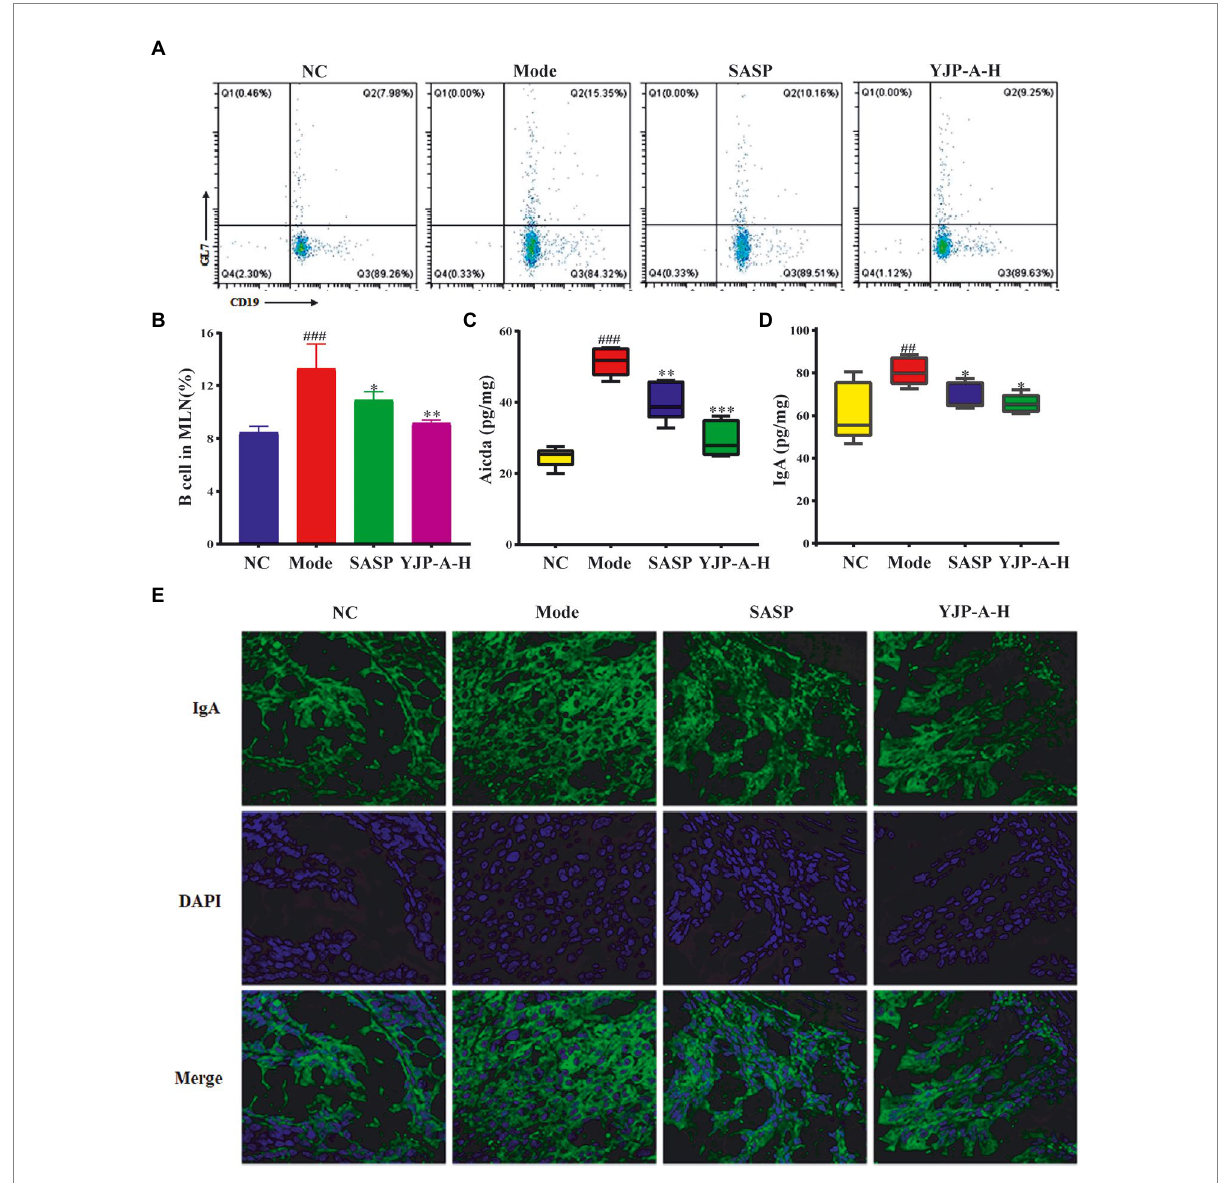
FIGURE 6 Effects of YJP-A-H on changes of B cells (A,B) , Aicda (C) in MLNs and IgA levels (D,E) in colon. Data are expressed as the mean ± SEM, except for flow cytometry assay n = 3 per group, the remaining analysis n = 5 per group. ## p < 0.01, ### p < 0.001 vs. NC group; * p < 0.05, ** p < 0.01, *** p < 0.001 vs. model